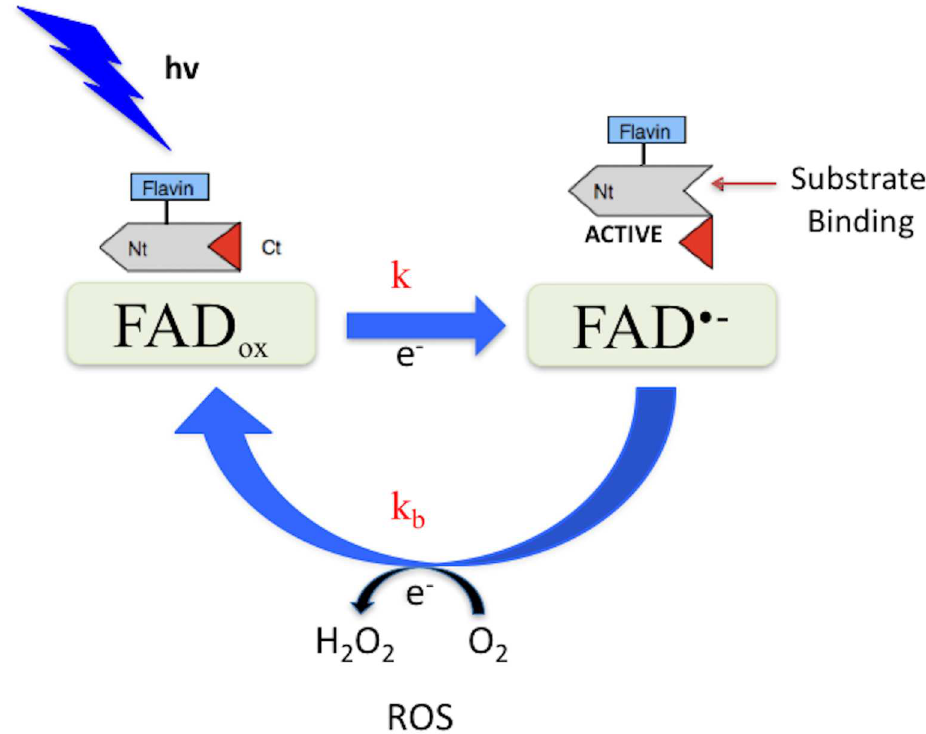
Fig 1. Possible Drosophila cryptochrome photocycle. In the dark, the protein-bound cofactor (FAD ox ) is shown in the oxidizedredox state. Light absorption triggers flavin photoreduction[12 – 14] at a rate constant k. Reoxidationto the FAD ox state occurs spontaneously in the dark at a rate constant k b . Possiblechangesin C- terminalconformation linked to redox state interconversion are diagrammed